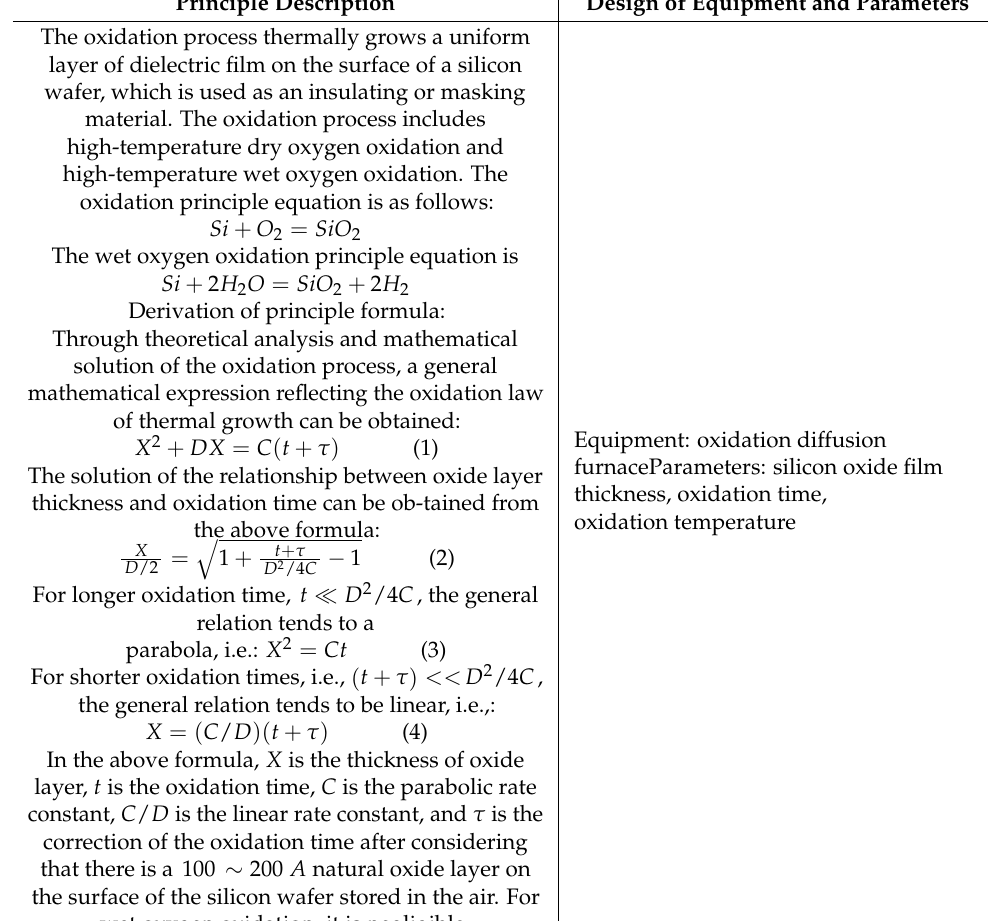
Table 3. The oxidation process as an example to illustrate the functional principle of the instrument and equipment